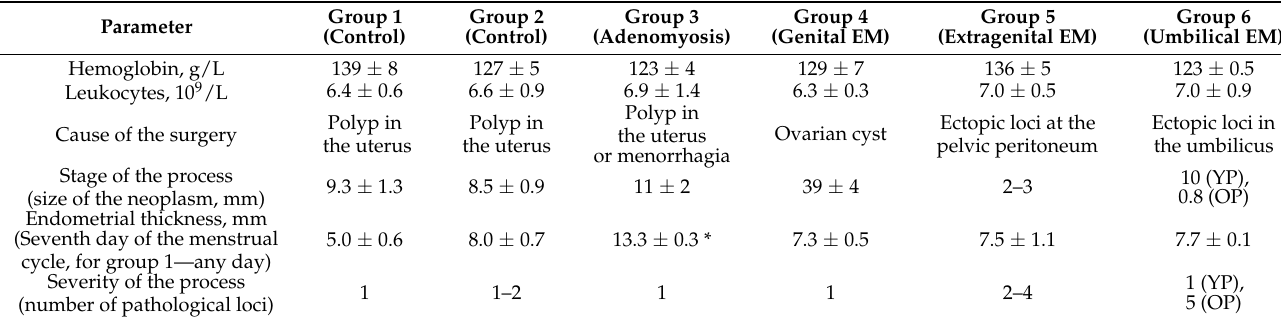
Table 3. The clinical and pathological parameters of the